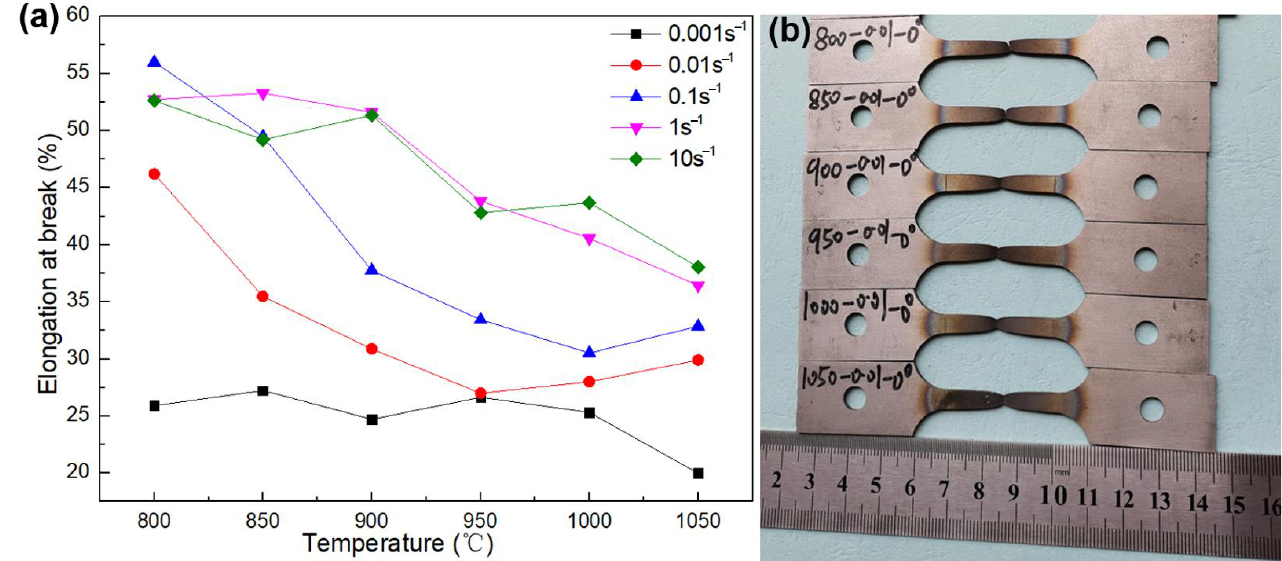
Figure 18. The elongation at break of all samples ( a ) and the fractured tensile samples ( b ).